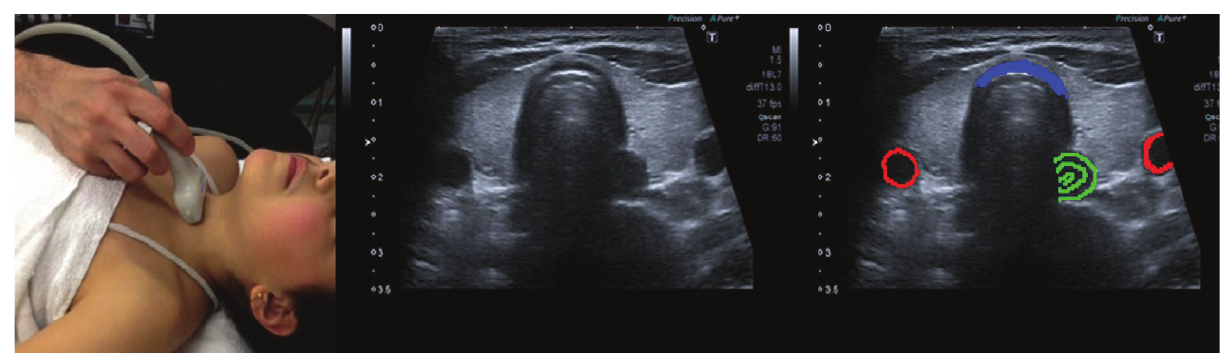
Figure 6. Technique of percutaneous needle cricothyroidotomy 3